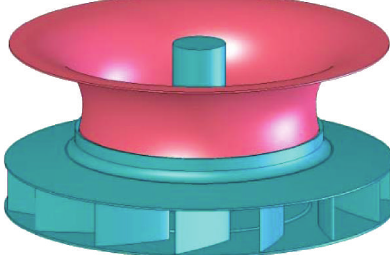
Figure 4: Bellmouth/impeller assembly for the B#1